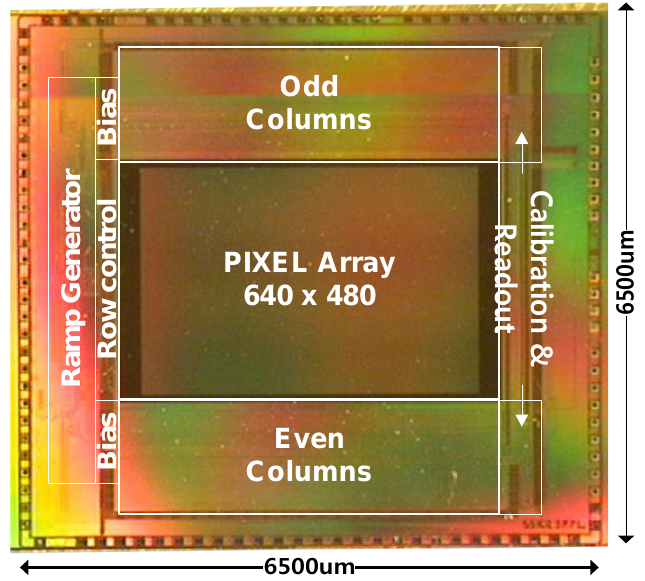
Figure 13. Microphotograph of the fabricated CIS with Samsung 0.13 μm CIS technology.